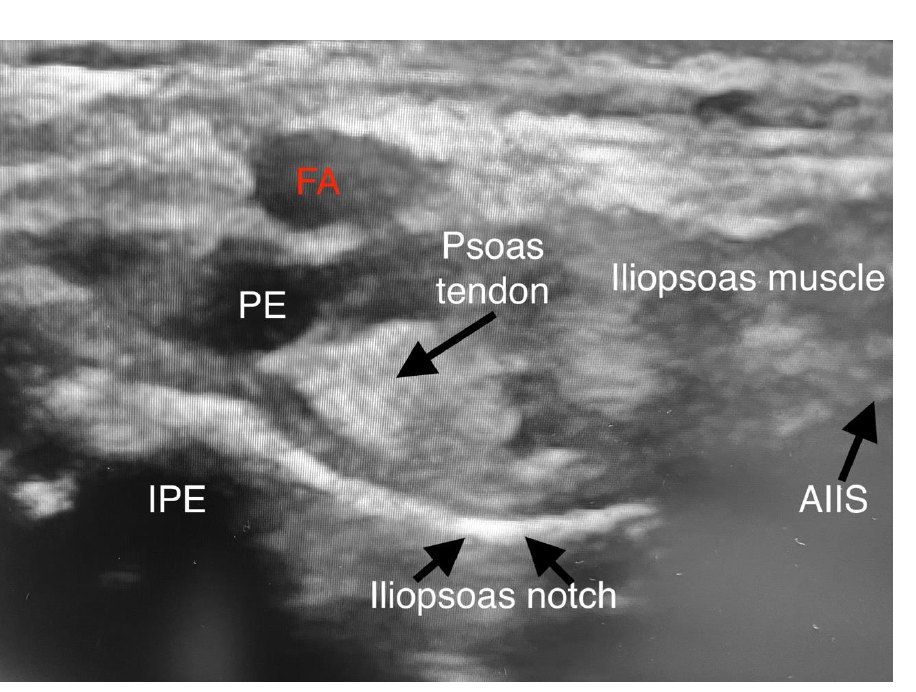
Figure 2. Injection technique of PENG block. (FA — femoral artery)